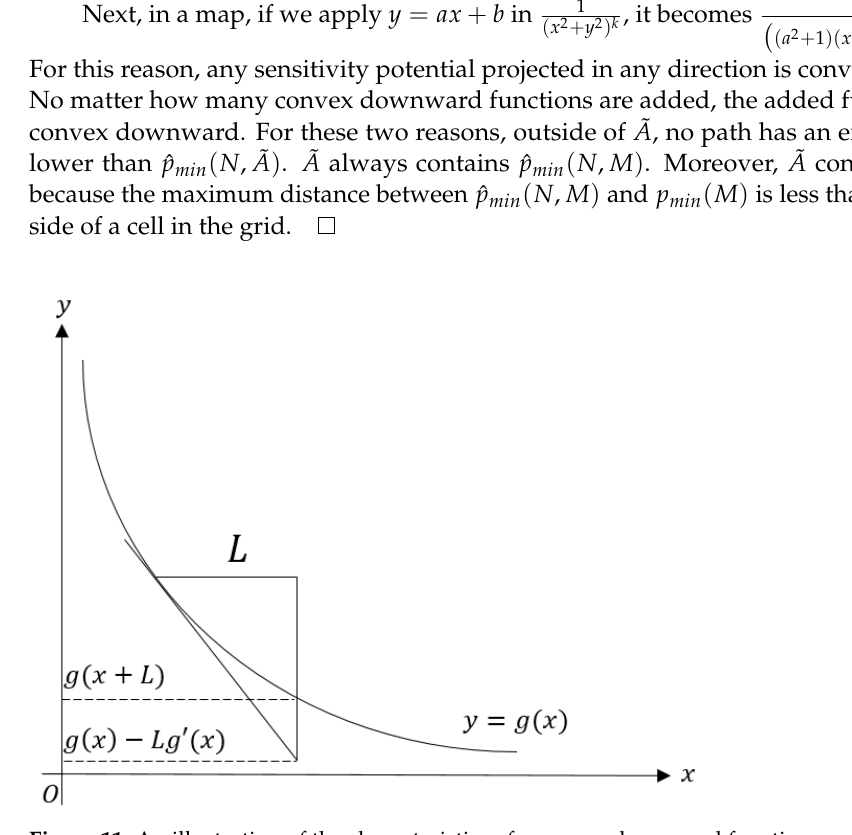
Figure 11. An illustration of the characteristics of a convex downward